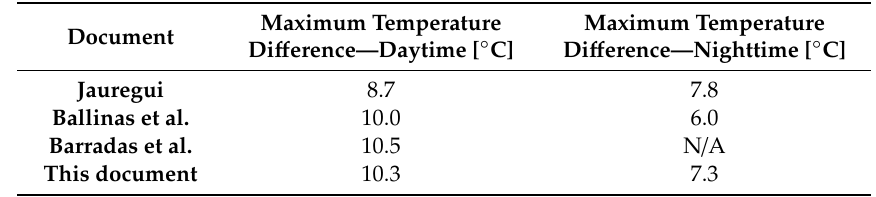
Table1. Comparisonofmaximumdi ff erenceoftemperaturewithandwithoutheatislandoffourstudies.